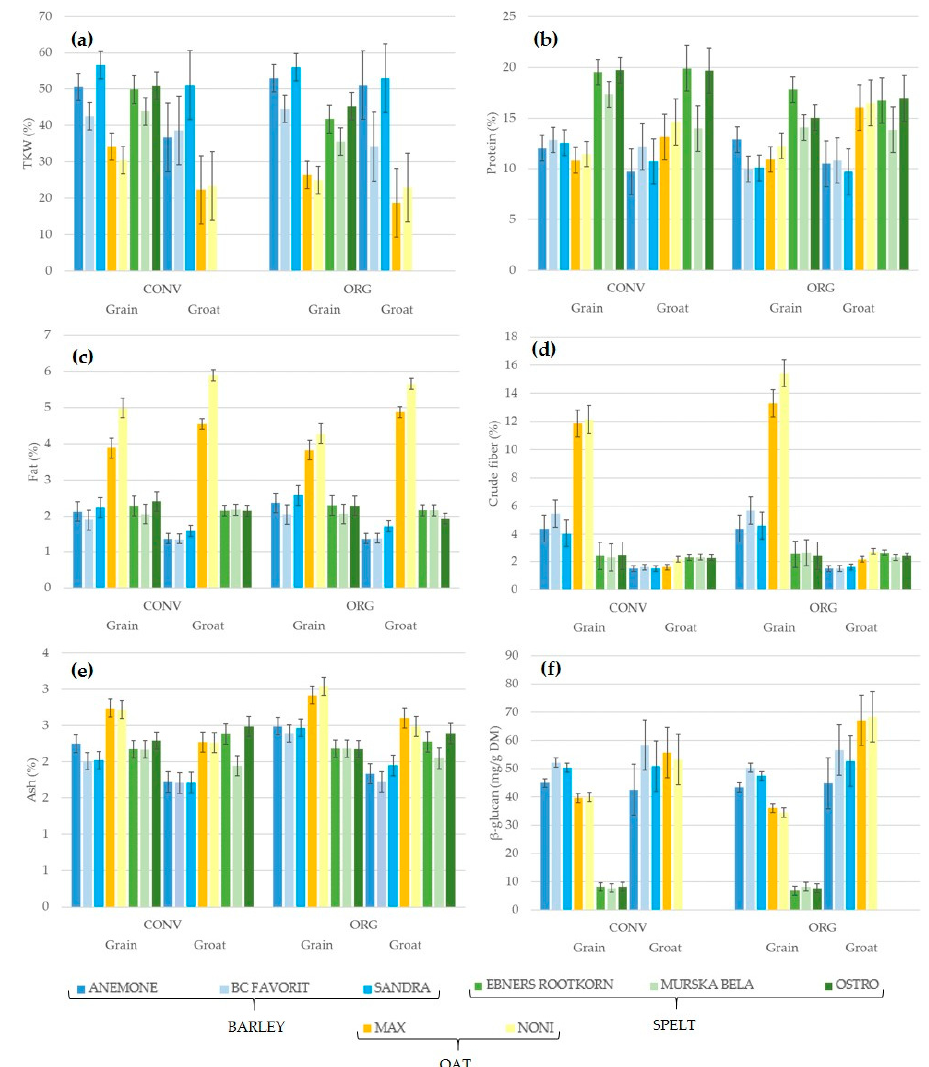
Figure 2. Compositional characteristics of grains and groats of barley, oat, and spelt varieties from conventional (CONV) and organic (ORG) farming: ( a ) TKW, thousand kernel weight; ( b ) protein; ( c ) fat; ( d ) crude fibre; ( e ) ash; and ( f ) β -glucan content. LSD 5% values indicate the difference between species/varieties; blue represents barley, orange and yellow represent oat, and green represents spelt